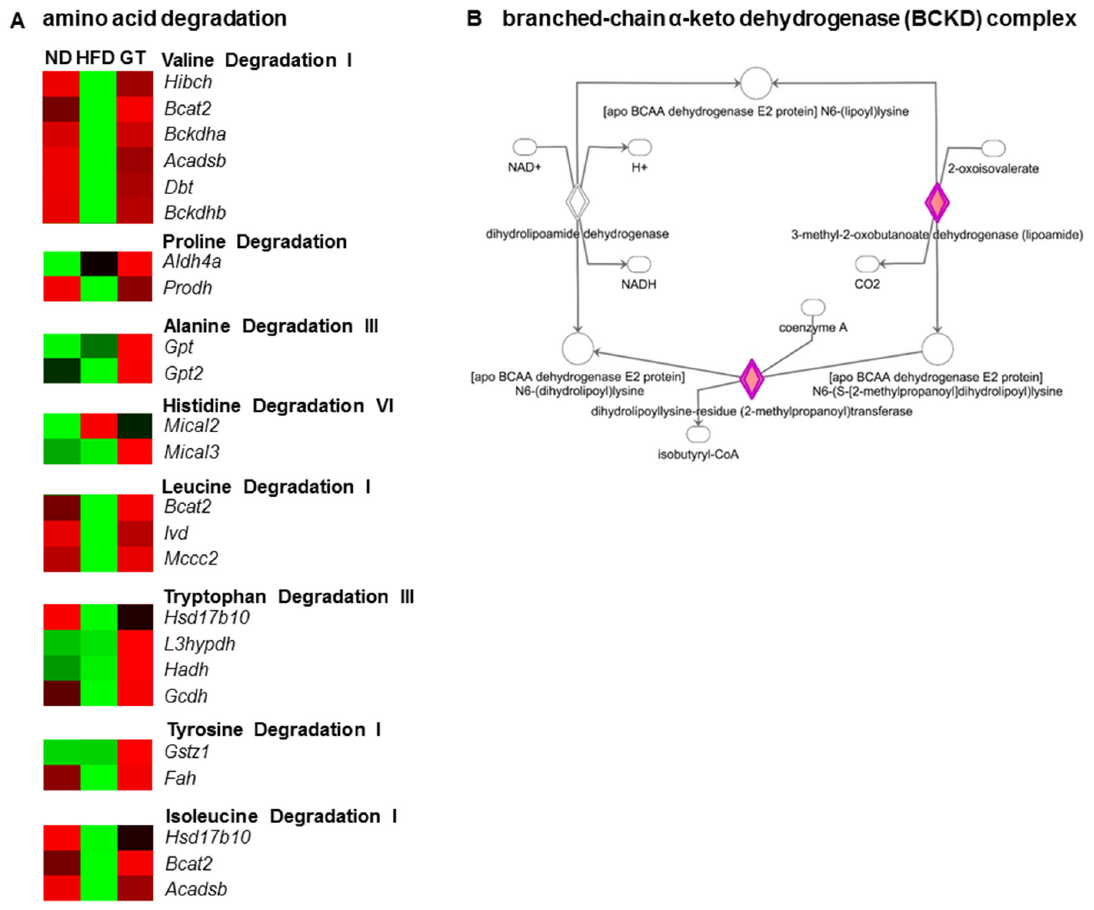
Figure 6. ( A ) A heat map of the genes involved in amino acid degradation; and ( B ) the transcriptional response related to branched ‐ chain α‐ keto dehydrogenase (BCKD) in the epididymal white adipose tissue (eWAT) of diet ‐ induced obese C57BL/6J mice treated with green tea extract for 12 weeks. The significant pathways were obtained via Ingenuity Pathway Analysis (IPA).